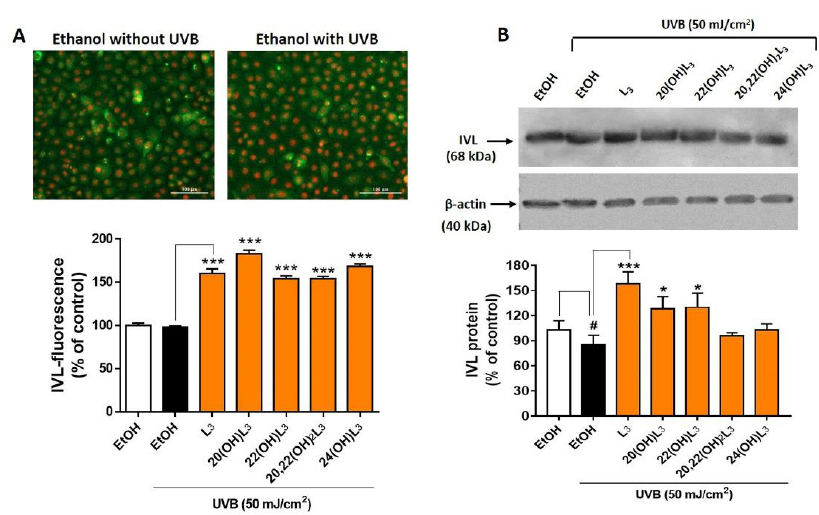
Figure 8. Lumisterol hydroxyderivatives stimulate the di ff erentiation in UVB-irradiated keratinocytes, as shown by increased involucrin (IVL) protein expression. ( A ) Fluorescent microscopy of cells stained with IVL antibodies was detected by the Cytation ™ 5 cell imaging, n ≥ 100 cells for each condition. Scale bar = 100 µ m. The single-color staining represents the expression in cytosol (green) and in nuclei (red), whereas the dual expression (orange–yellow) represents the expression in both cytosol and nucleus. ( B ) Western blot analysis of IVL (68 kDa). Data were normalized relative to β -actin (loading control) and are presented as the % of ethanol control (mean ± SD, n = 3). The statistical significance of di ff erences between the control non-irradiated cells (white bar) and the UVB-irradiated cells (black bar) was evaluated by Student’s t-test, and between UVB-irradiated control and lumisterol-treated cells (dark orange bars in the chart) by one-way ANOVA with Dunnett’s multiple comparison test. # p < 0.05 versus non-irradiated control cells. * p < 0.05 and *** p < 0.001 versus untreated cells exposed to UVB.